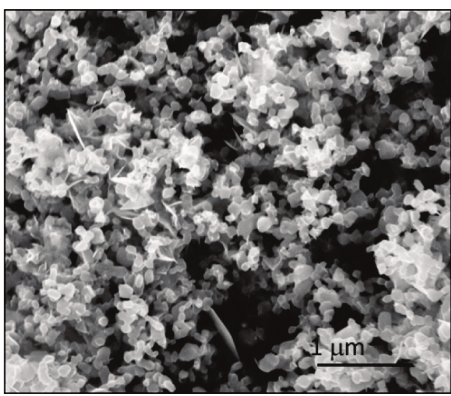
Figure 9. IF-WS generated at 900 °C from the WO 2 atmospheric plasma system. Despite the highly spherical nature of the precursor, the IF-WS particulates present facets and polyhedral shapes. A few atoms thick 2D WS 2 also